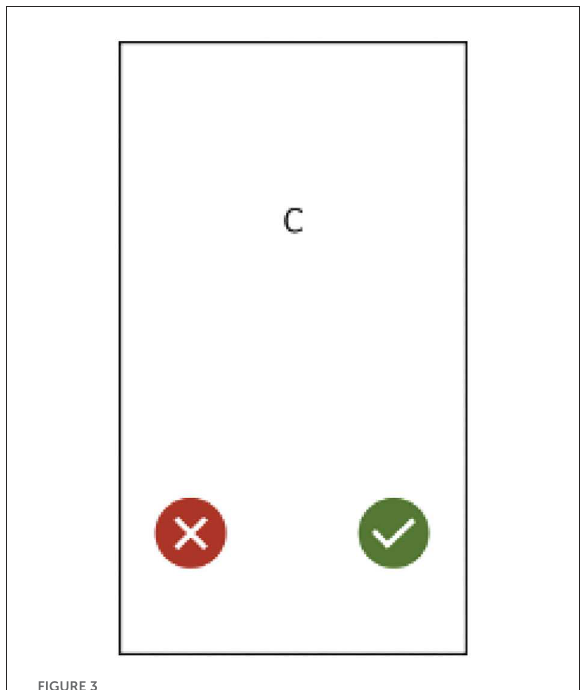
FIGURE3 A screenshot of the N-back